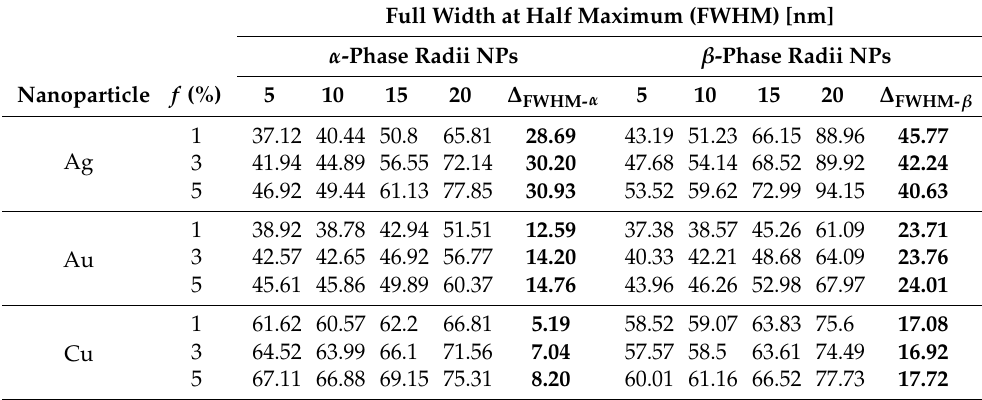
Table 2. Full width at half maximum values of resonant peaks at different phases of MoO 3 thin films doped with different nanoparticles at different volume filling fractions ( f ).